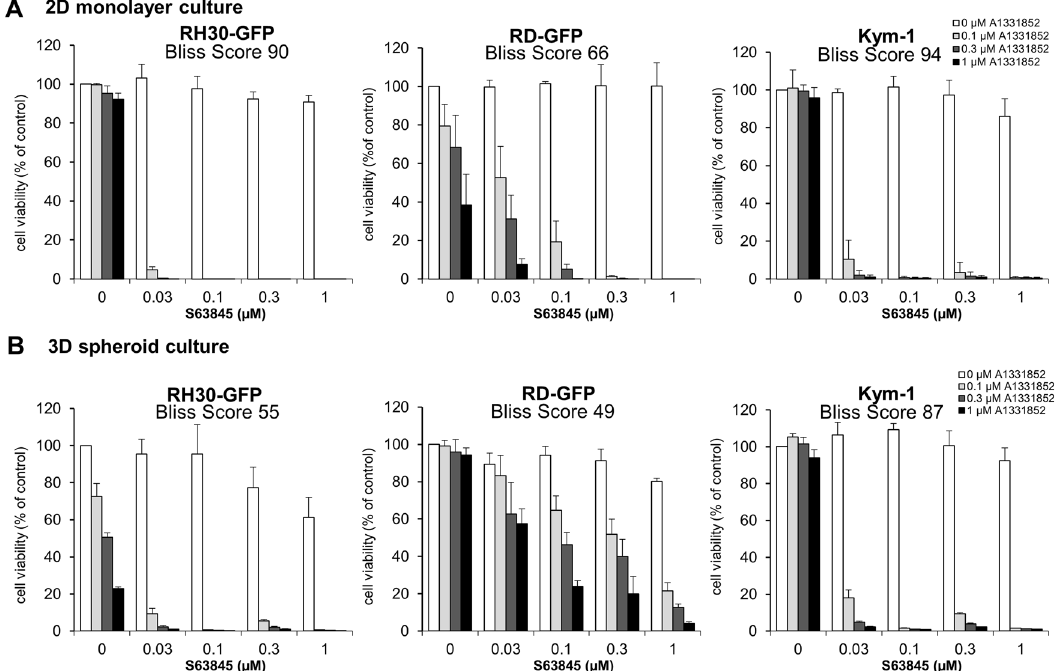
Fig. 2 Cell death induced by BH3 mimetics in 2D and 3D cultures. A RH30-GFP, RD-GFP and Kym-1 cells were cultured as adherent monolayer cells (2D) before treatment with different concentrations of BH3 mimetics for 48 h. Viability was analyzed using Cell Titer Glo ® assay. B RH30-GFP, RD-GFP and Kym-1 cells were cultured as spheroids (3D) for 3 days before treatment with different concentrations of BH3 mimetics for 48 h. Viability was analyzed using CellTiter-Glo ® assay. Data shown are mean + S.D. ( n = 3). Synergy was quanti fi ed using Synergy fi nder and expressed as Bliss Score with a score >0 indicating synergy on a scale to